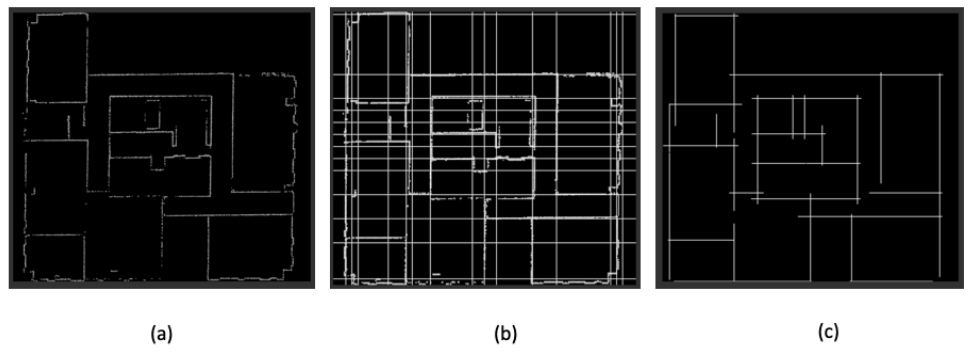
Figure 3. Result of the wall detection process for seventh floor of the Robot Convergence Building at Korea University: ( a ) result of the depth image, ( b ) results of horizontal and vertical lines, and ( c ) results of walls.